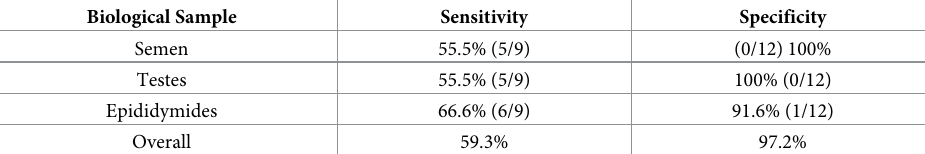
Samples were declared as positive in PMCA if at least two of the triplicates gave a protease-resistant PrP Sc signal in any of the PMCA rounds analyzed.